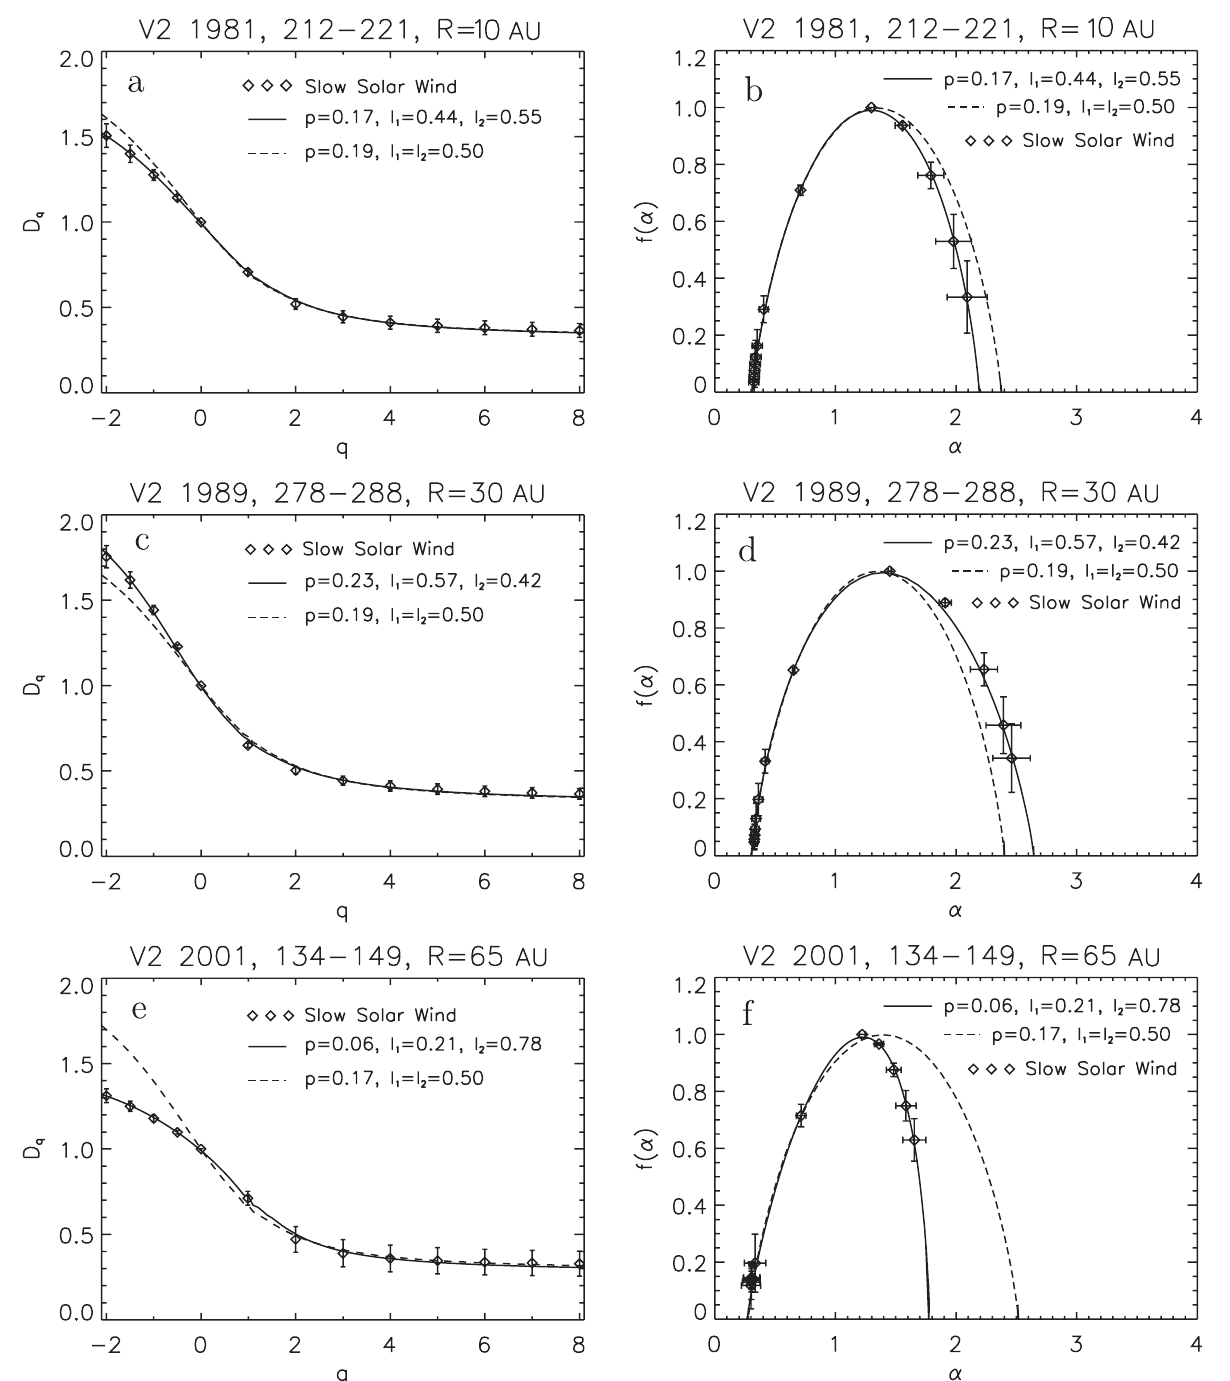
Fig. 3. The generalized dimensions D q (a, c, e) and singularity spectra f (α) (b, d, f) calculated for the one-scale p -model (dashed lines) and the generalized two-scale (continuous lines) models with parameters fitted to the multifractal measure µ(q,l) using data measured by Voyager 2 during solar maximum (1981, 1989, 2001) at 10, 30, and 65 AU (diamonds) for the slow solar